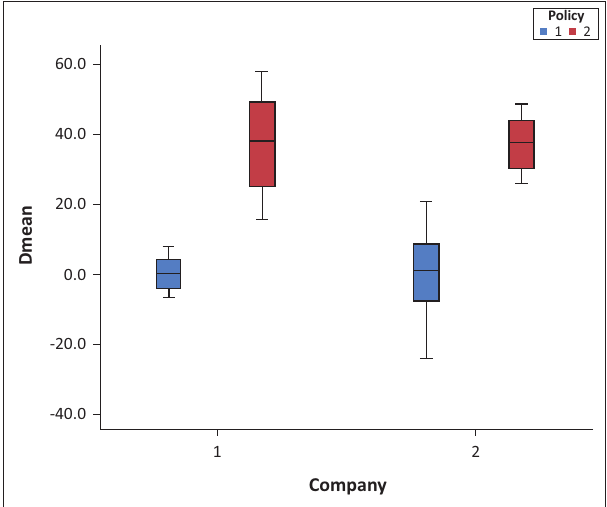
FIGURE 1: Box plots determining the normality and homogeneity of variance. TABLE 8: Levene’s test of equality of error variances F